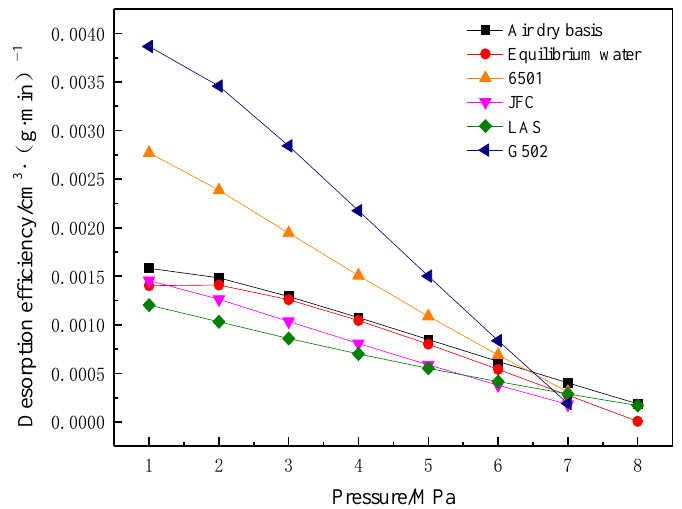
Figure 16. Changes in desorption efficiency of samples with different surfactants. (3) Desorption hysteresis